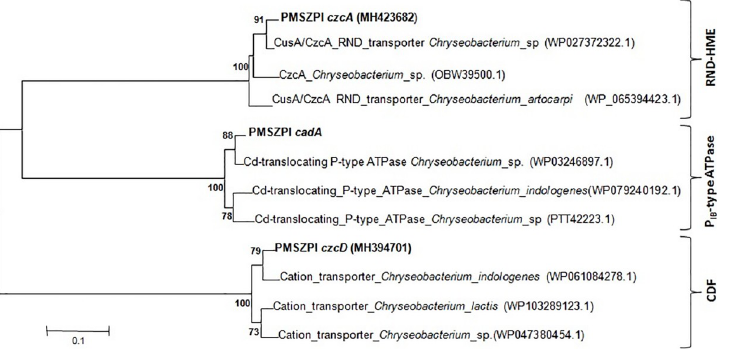
Fig 2. Phylogenetic analysis of CDF, RND-HME and P IB -type ATPases. Neighbor-joining method of translated amino acid sequences from czcD , czcA and cadA genes were carried out using MEGA.6.0 software with 1000 bootstrap